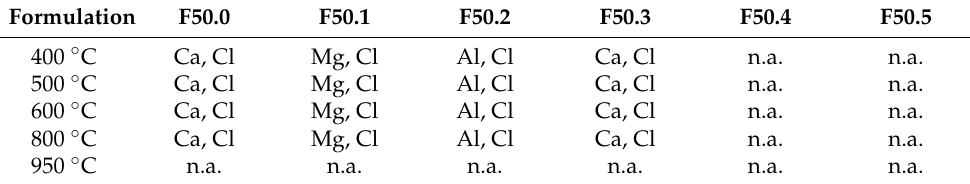
Table 9. Main elements in ashes detected by XRF.